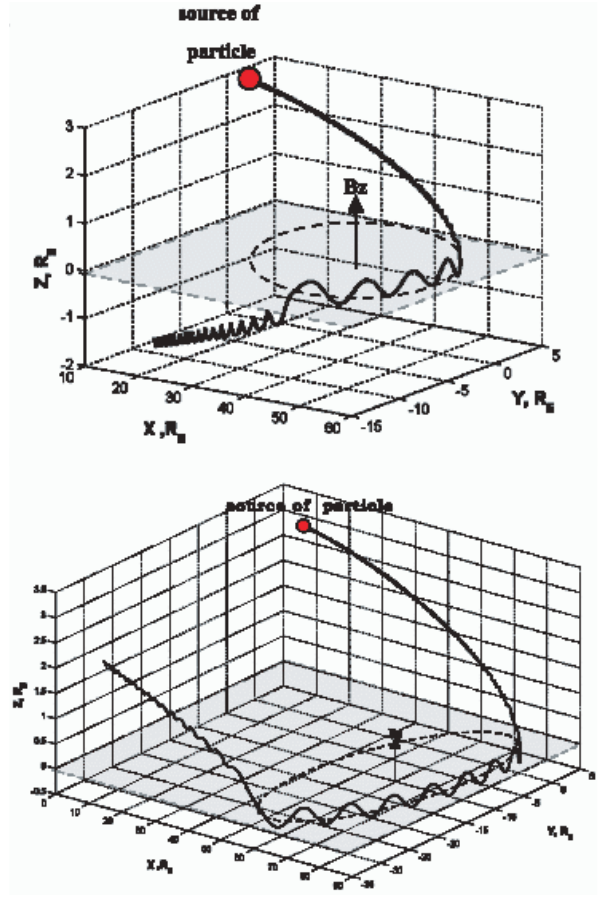
Fig. 45. Trajectories of non-adiabatic ions in the de Hoffman-Teller coordinate frame. The picture illustrates the combination of me- andering motion and slow rotation in the B z field. Both trajectories shown correspond to the resonance condition when the chaotic scat- tering is almost absent. (a) even resonance ( N =8): entry/exit are in opposite hemisphere; (b) odd resonance ( N =15): entry/exit are in the same